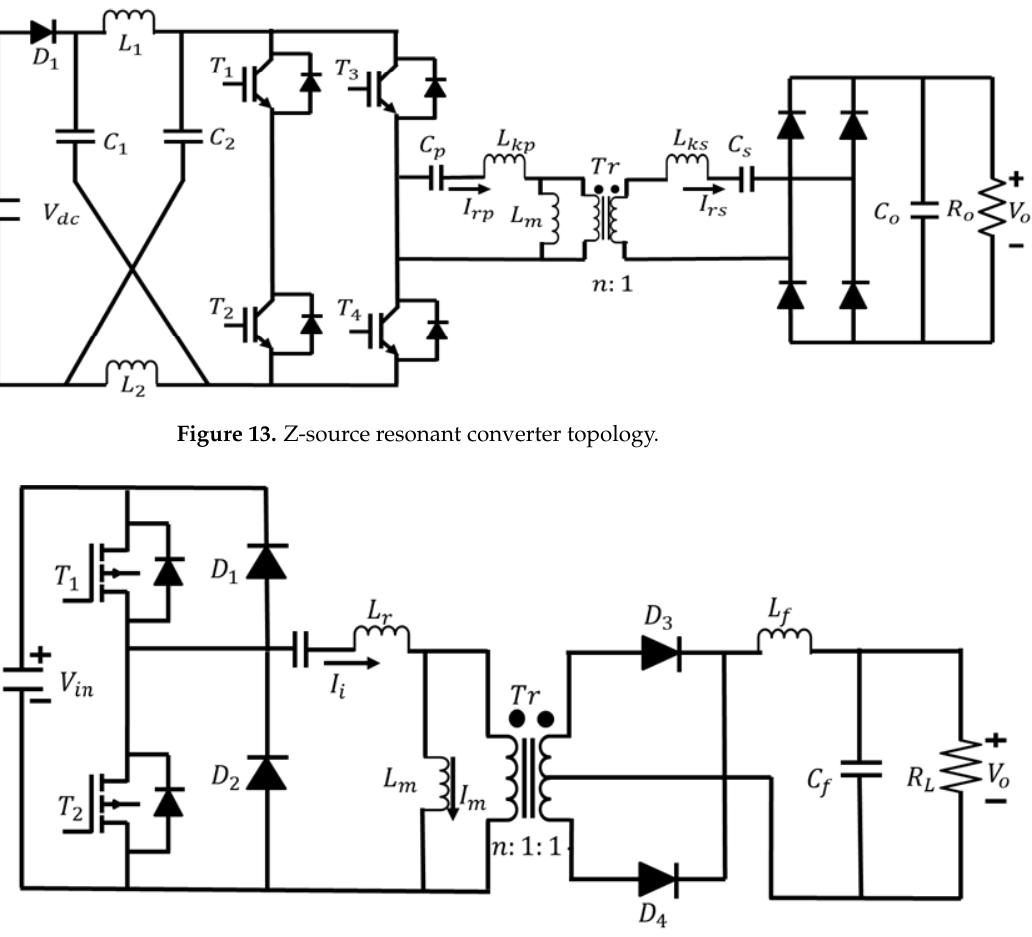
Figure 14. Converter topology for Interior Permanent Magnet Synchronous Motor (IPMSM).